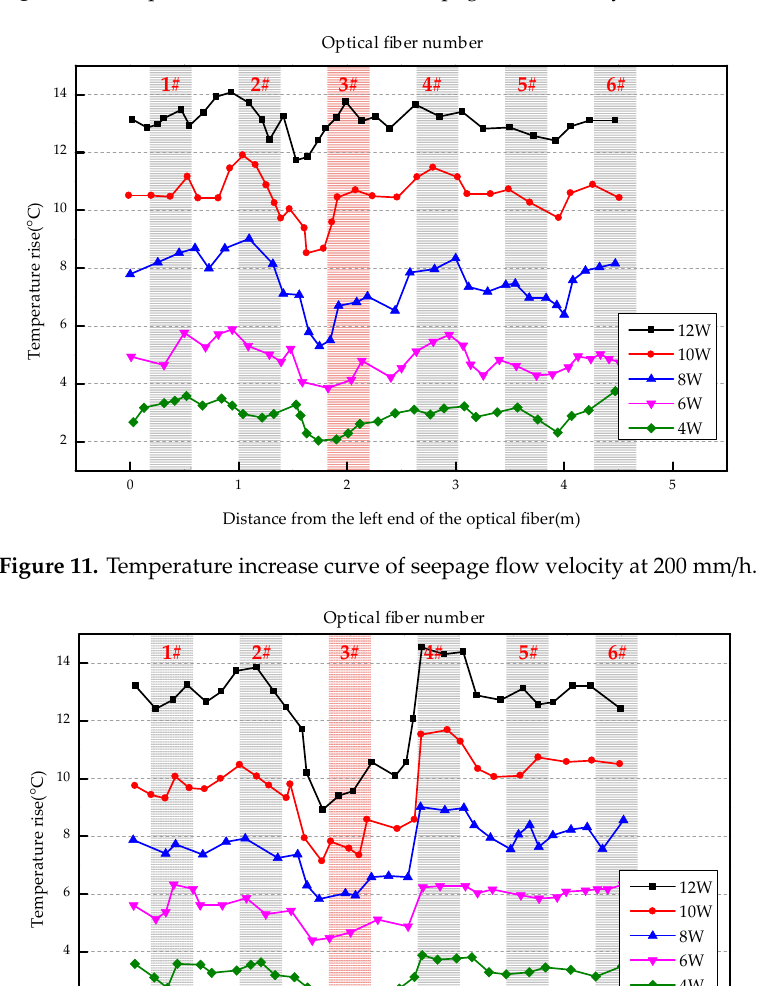
Figure 10. Temperature increase curve of seepage flow velocity at 150 mm/h.